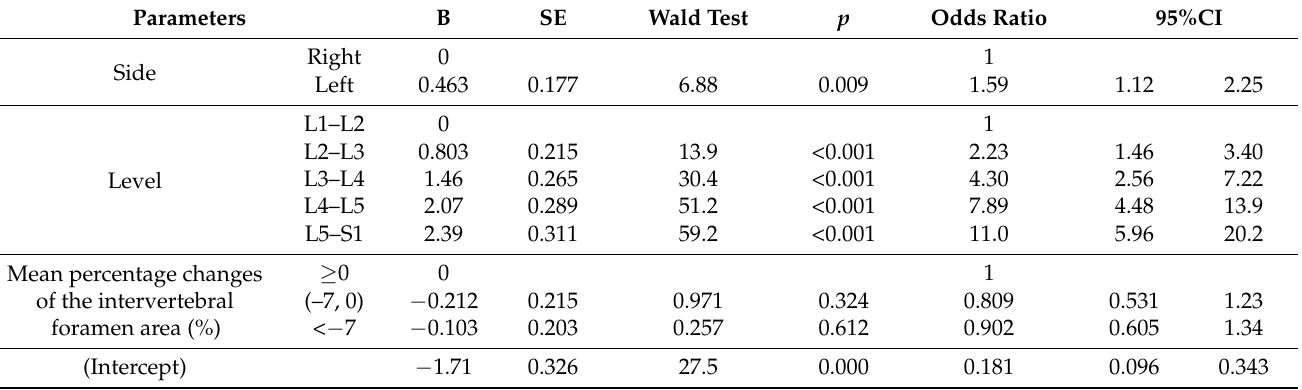
Table 4. Parameters of the generalized linear model for the “dermatomal pain” dependent